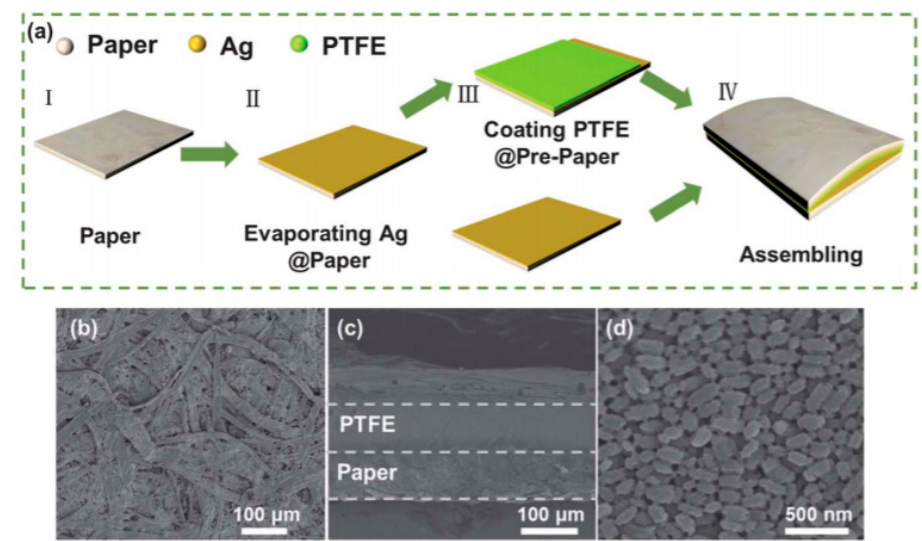
Figure 37. ( a ) Scheme illustrating the fabrication process of the paper generator. ( b—d ) SEM images of the paper coated with an Ag layer ( left ), the cross-section of the Ag-paper covered by PTFE ( middle ) and the top view of the Ag–paper after spin-coating with PTFE. Reproduced from [160]. Copyright 2013, The Royal Society of Chemistry.